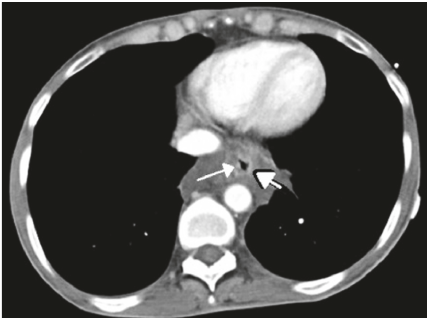
Figure 1: CT scan of the upper abdomen. Low-attenuation sur- rounding the distal esophagus with esophageal wall thickening